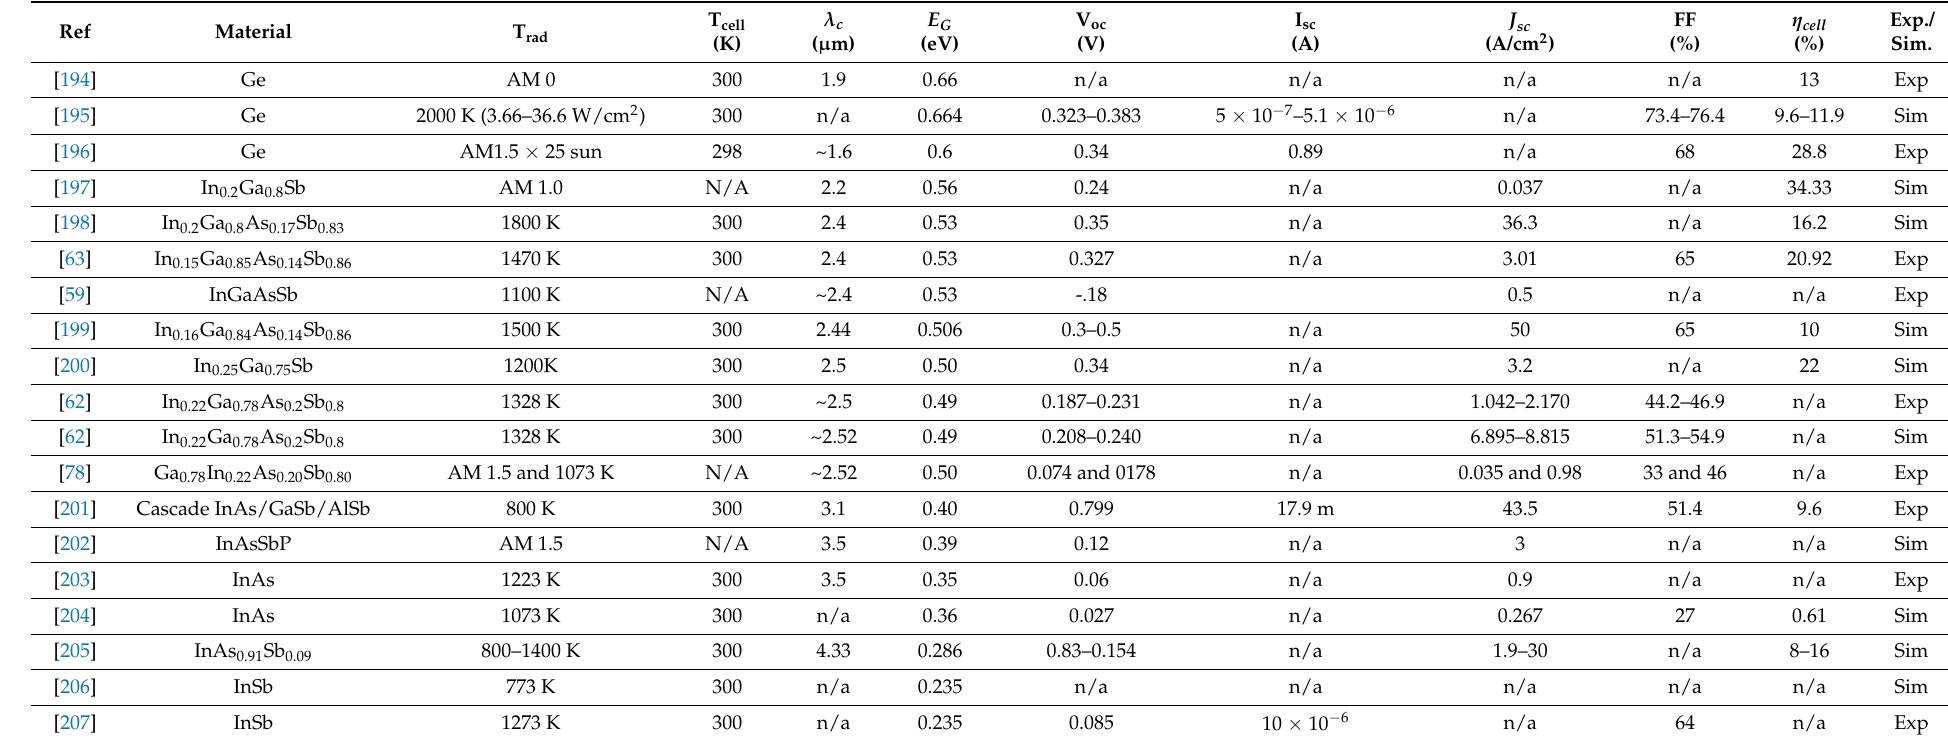
Table 5. Narrow Bandgap Materials TPV